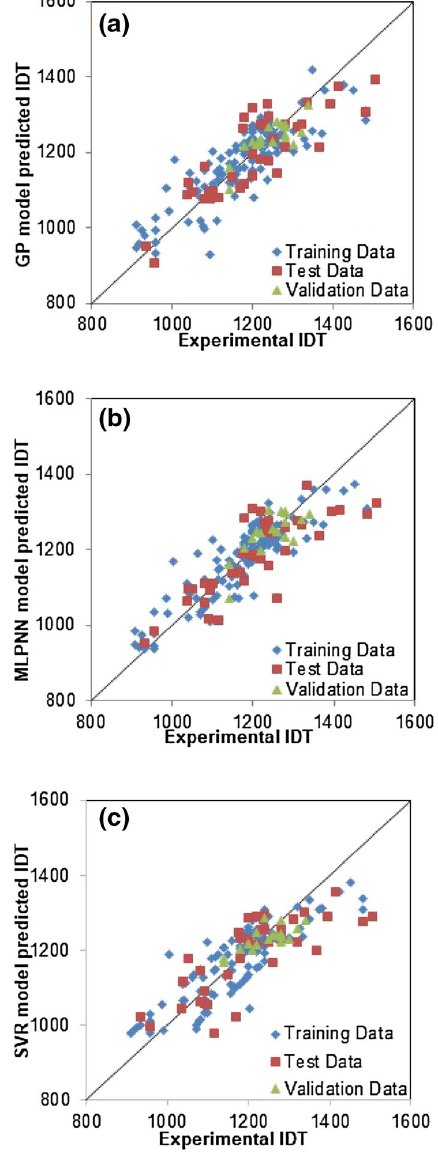
Fig. 8 Plots of the experimental IDT values versus those predicted by the GP (panel a ), MLP (panel b ), and SVR based (panel c )